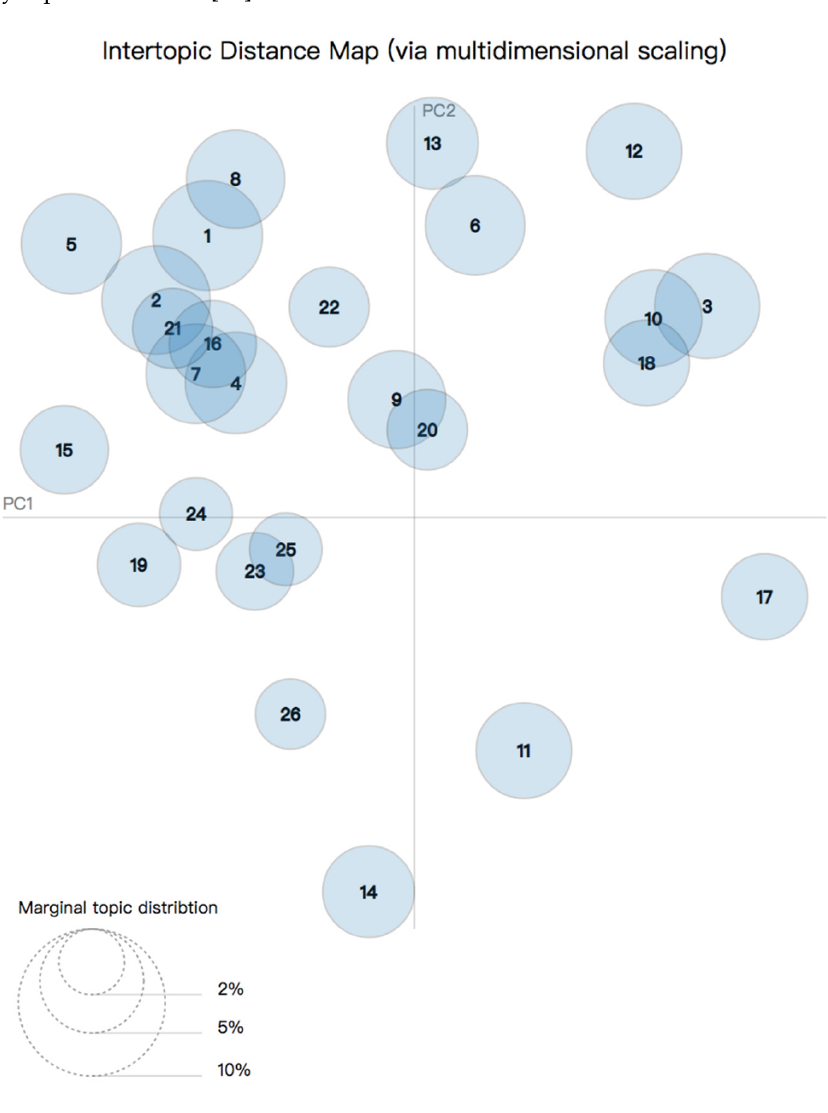
Figure 4. Inter-topic distance map for e-cigarettes (Topic numbers are marked in the circle).